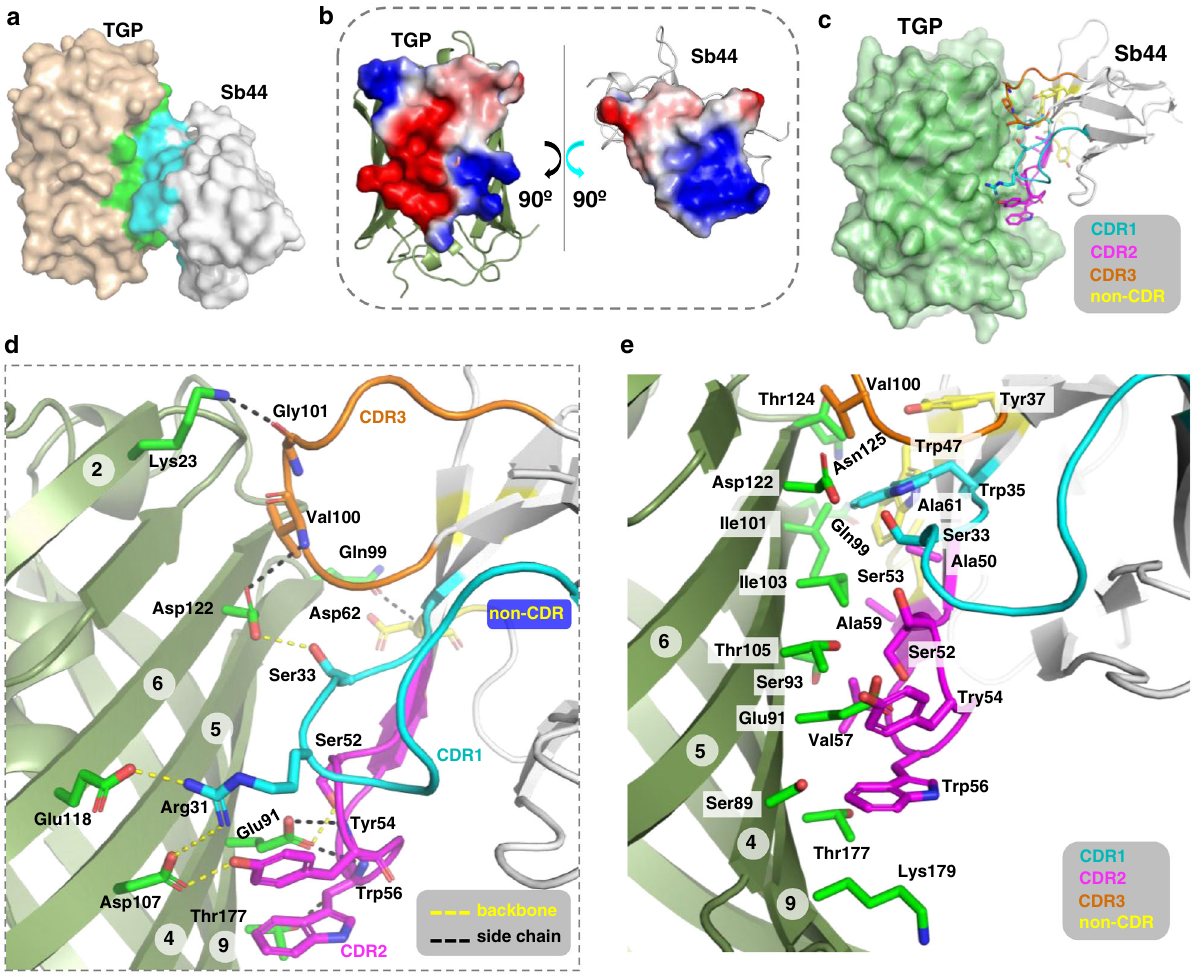
Fig. 8 Crystal structure of the TGP-Sb44 complex. a Surface representation with interface residues colored green (TGP) and cyan (Sb44). b ‘ Open-book ’ representation of the electrostatic potential molecular surface generated using the Adaptive Poisson-Boltzmann Solver 79 module in PyMol 90 . c Sb44 binds with its concave surface to TGP. Interacting non-CDR and CDRs residues are shown as sticks with carbon atoms in indicated colors. d Salt bridges and H- bonds between TGP and Sb44 with a cutoff distance of 3.9 Å. Yellow dash lines (5) indicate interactions between side chains. Black dash lines (6) indicate H-bonds that partly contributed by backbone atoms. e Hydrophobic interaction network formed by hydrophobic residues or the apolar part of hydrophilic residues. Circled numbers indicate TGP β -strands. CDR complementarity-determing region, TGP thermostable green fl uorescent protein, sybody synthetic